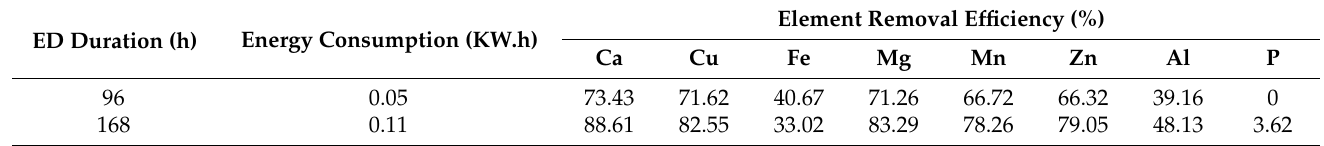
Table 3. Element removal efficiency of 200 mL P extract for 96 h and 168 h under 50 mA and energy consumptions.